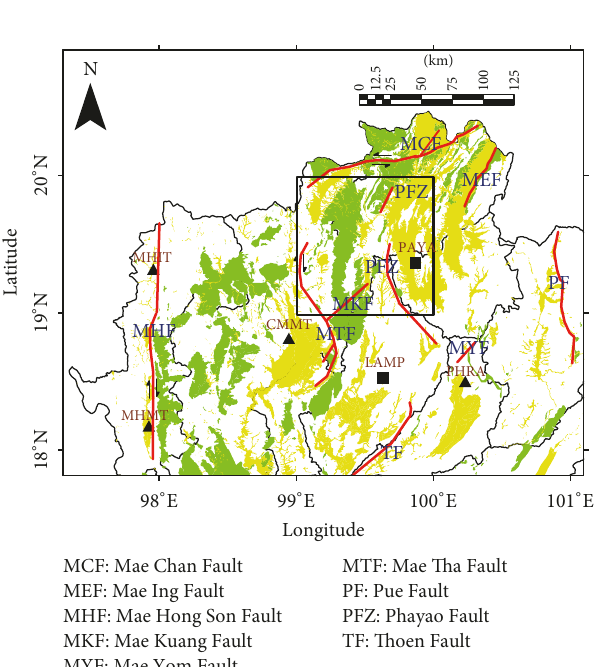
Figure 1: Geological and tectonic setting of Northern Thailand. Overview of Northern Thailand consists of main active faults (red lines), granite rocks (green), and tertiary basins (yellow). Black triangles and black solid squares are marked as broadband and short-period stations, respectively. A topological map related to Figure 2 indicates the study area marked as a black solid square.